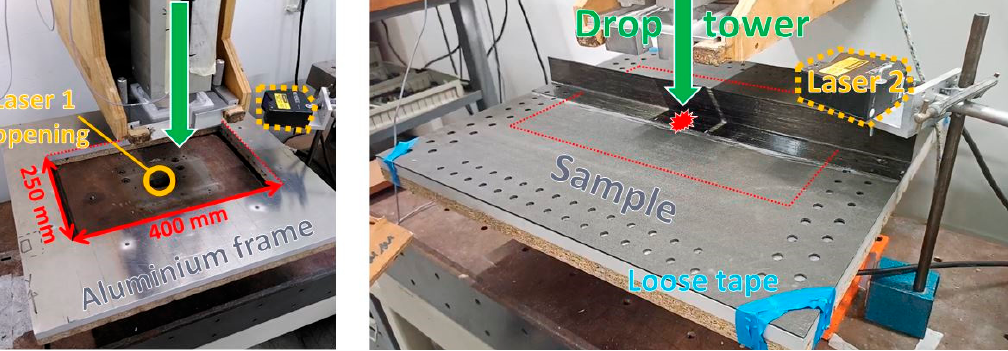
Figure 15. Setup used to impact the samples with a drop tower system: ( left ) frame alone with a 400 mm × 250 mm opening, ( right ) sample positioned on the frame.